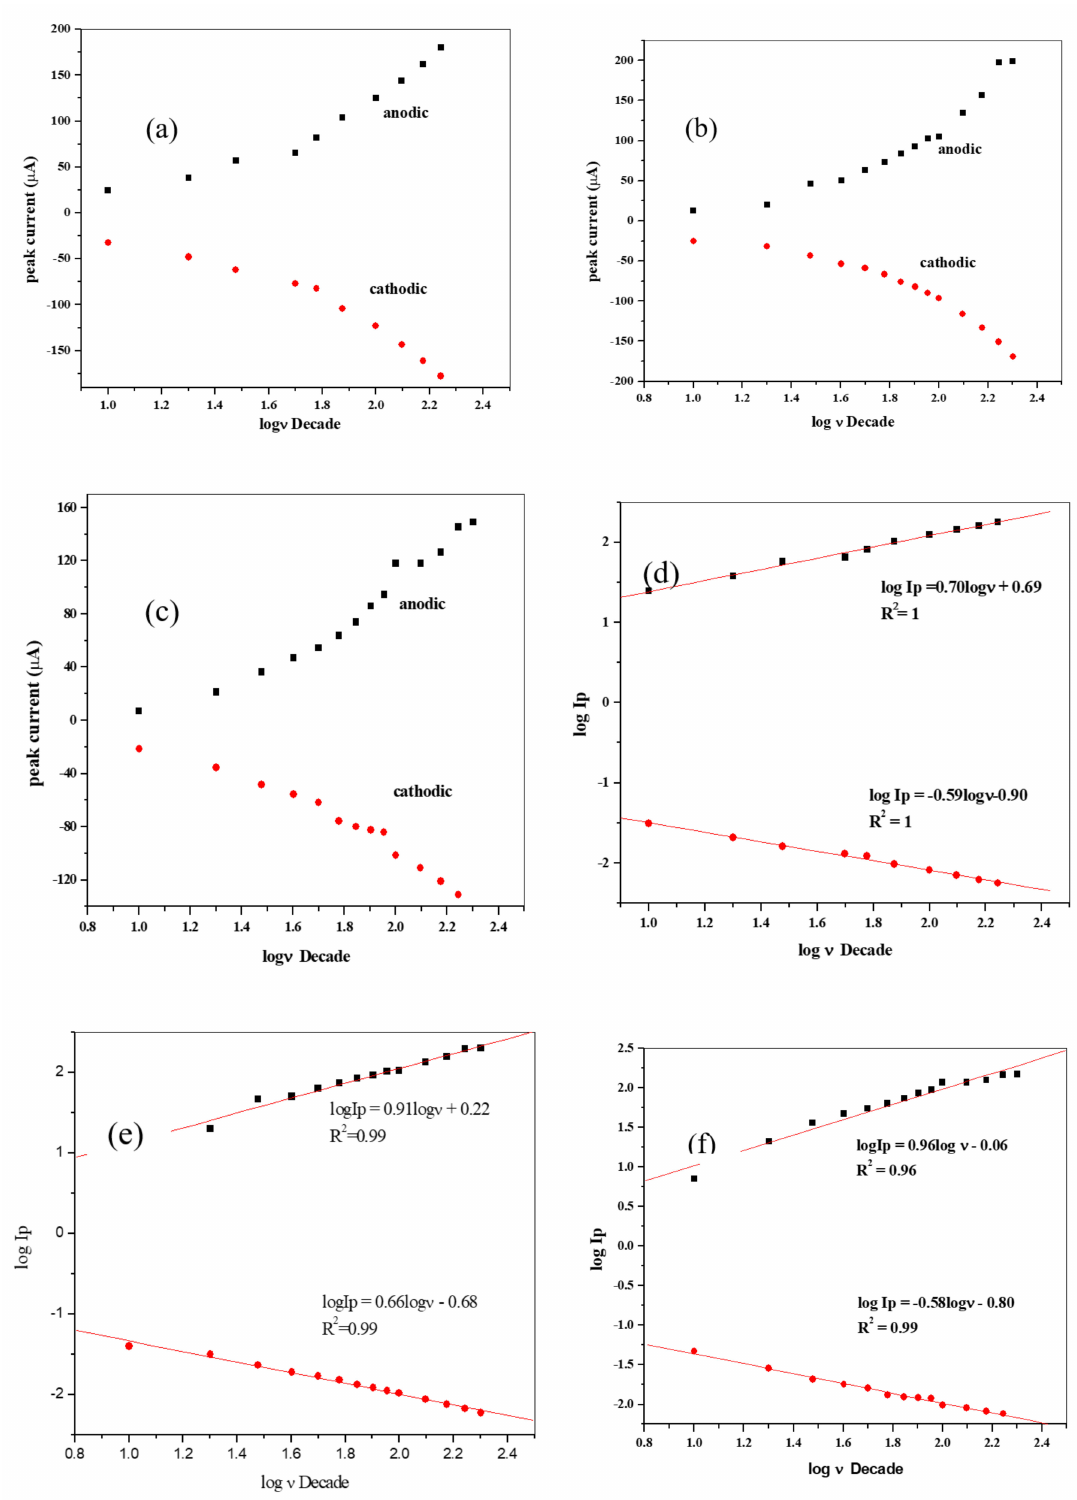
Figure 13. The plot of log of peak current vs. scan rate for ( a ) SPE / LPE / ZnO NPs, ( b ) SPE / GPE / ZnO NPs, and ( c ) SPE / OPE / ZnO NPs and log of peak current vs. log of scan rate for ( d ) SPE / LPE / ZnO NPs, ( e ) SPE / GPE / ZnO NPs, and ( f ), SPE / OPE / ZnO NPs in 10 mM K 3 [Fe(CN) 6 ] in 0.1 M KCl at pH ≈